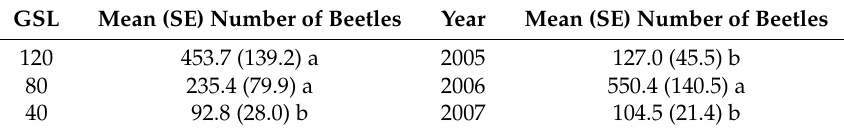
Table 1. Mean (SE) number of Dendroctonus ponderosae beetles caught in passive Lindgren funnel traps (no attractants), in Pinus contorta stands with growing stock levels (GSL) of 40, 80, and 120 across all years and per year across all GSL levels. Three traps were deployed in five replicates of each GSL level. Different letters within columns denote significant differences at p < 0.05, Tukey’s studentized range test, n = 15 for all GSLs, Fraser Experimental Forest, CO, 2005–2007.